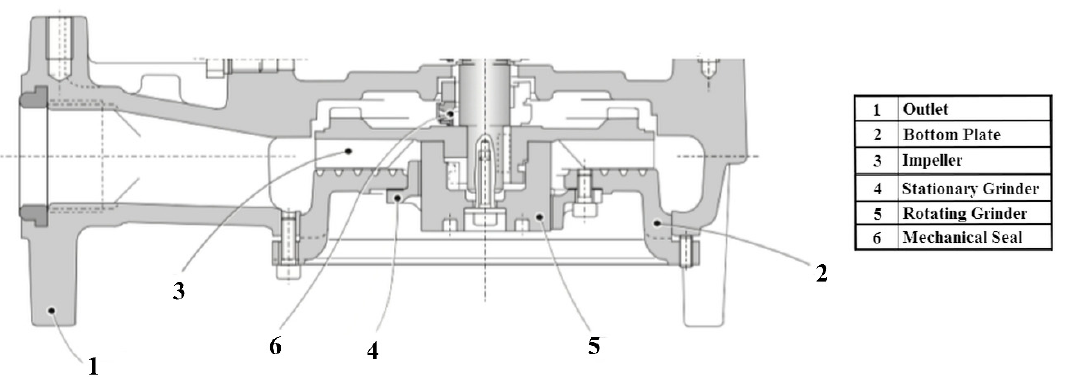
Figure 2. A detailed section of the tested Caprari K series pump.